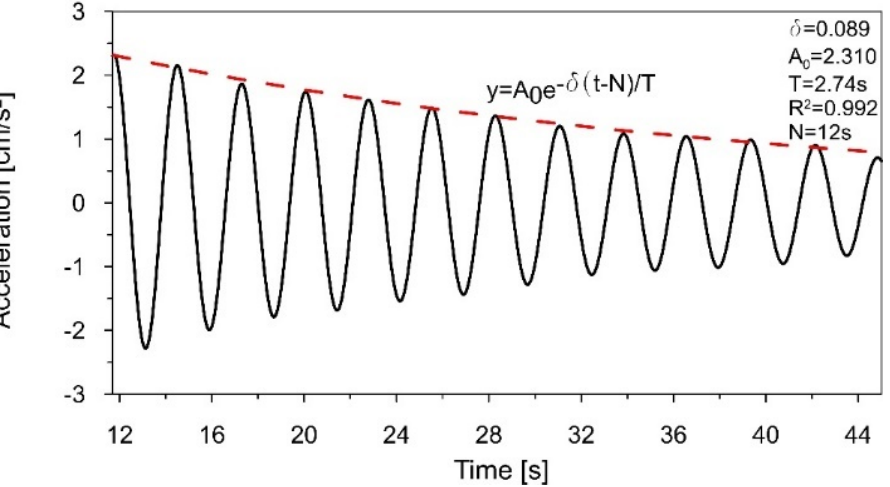
Figure 11. The fragment of the acceleration − time history, filtered around the first natural frequency f 1 = 0.365 Hz that served to estimate the logarithmic decrement of damping δ 1 = 0.089. The same procedure was introduced to find the logarithmic decrement of damping and the damping ratio corresponding to the second natural frequency f 2 = 1.570 Hz. The obtained values were δ 2 = 0.132 and ξ 2 = 2.10%, respectively. It is worth noticing that the obtained values of damping ratios, ξ 1 = 1.41% and ξ 2 = 2.10%, are in good agreement with data accessible in literature for high concrete chimneys